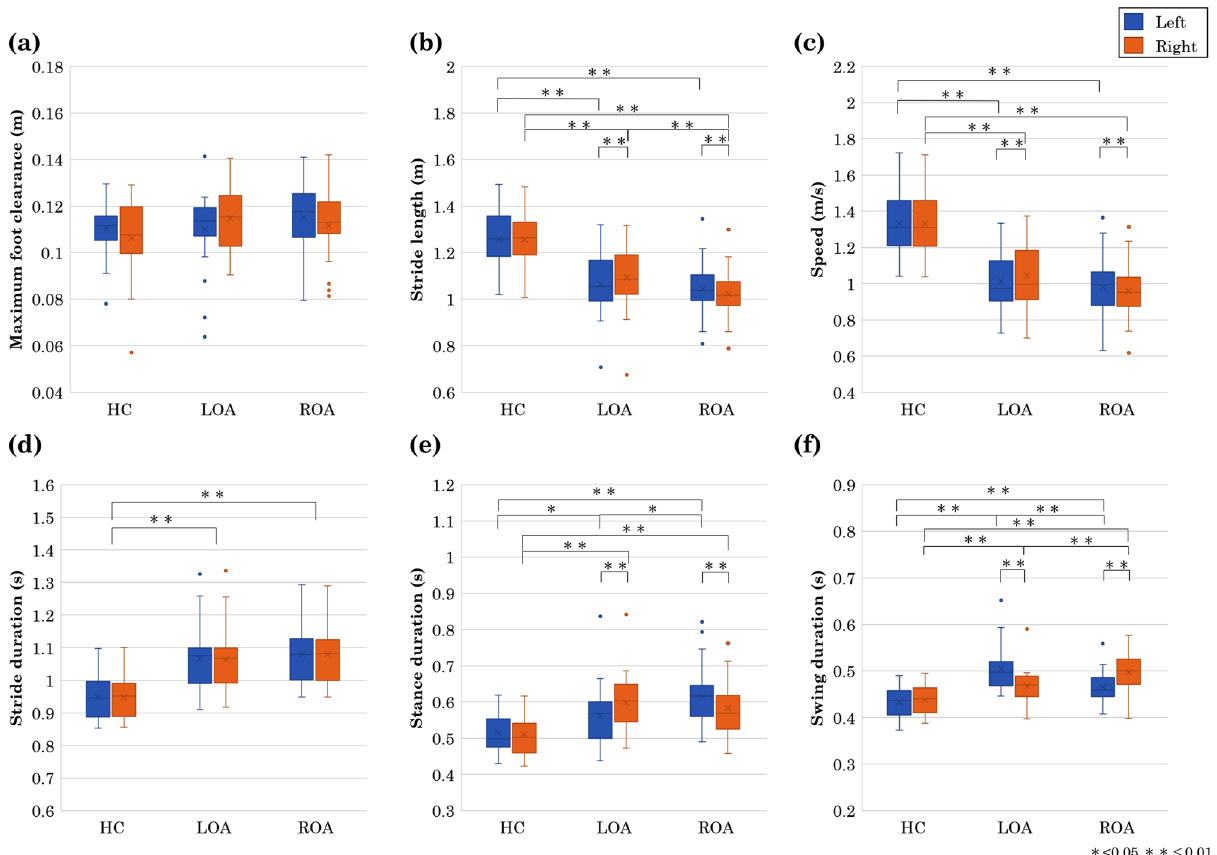
Figure 3. All gait parameters of ( a ) maximum foot clearance, ( b ) stride length, ( c ) speed, ( d ) stride duration, ( e ) stance duration, ( f ) swing duration. Blue is the left leg, orange is the right leg, and error bars indicate the SD. From left to right: healthy control (HC), left hip osteoarthritis (LOA), right hip osteoarthritis (ROA). * indicates significance at p < 0.05 and ** indicates significance at p < 0.01 from the midline was examined with the swing leg side as (+) and the stance leg side as (-) (Fig. 2h,i). The LD farthest from the midline to the swing legs side was defined as the maximum, and the LD closest to the stance legs side was defined as the minimum (Fig. 2h). In the sagittal plane, the stride length of the patient with hip OA is shorter than that of the HC, but the maximum foot clearance does not seem to be significantly different (Fig. 2d). Therefore, the foot trajectory of the patient with hip OA shrinks only in the direction of walking. The foot trajectory in the horizontal and frontal planes of the HC and the patient with hip OA appears to be very dif- ferent (Fig. 2e,f). The foot trajectory in the horizontal and frontal planes are in approximate symmetry in the HC, but in asymmetry and varied in the patient with hip OA, and the foot trajectory of the unaffected side is more medial than that of the affected side(Fig. 2e,f). In addition, the foot trajectory of the affected side of the patients of hip OA did not go medially, but spread laterally in some patients. However, the variation could be caused by individual differences(Fig. 2e,f). Therefore, the three-dimensional foot trajectory also appears to have a larger variation for the unaffected side limb of the ROA than the affected side limb of the LOA(Fig. 2b,c). Due to space limitation, we show only important statistical results. All results of the statistical test are shown in the supplementary information. Spatial gait parameters. The spatial gait parameters of the left and right lower limbs for HC, LOA, and ROA, i.e., maximum foot clearance and stride length are shown in Fig. 3a,b. Mixed ANOVA was performed for the mean of each gait parameter of HC, LOA, and ROA (Supplementary Table S1). Because significant interac- tions were found in the maximum foot clearance ( F ( 2, 72 ) = 3.94 , p = 0.024 , η 2 p = 0.099 )and stride length ( F ( 2, 72 ) = 11.82 , p < 0.001 , η 2 p = 0.247 ), we conducted the post hoc test for these gait parameters. When the simple effect of the group was found, we conducted a multiple comparison using Shaffer’s method. The results are shown in Table 2. For maximum foot clearance (Fig. 3a), there was no significant different between HC, LOA, and ROA. The stride lengths (Fig. 3b) in patients with LOA and ROA were significantly shorter in both the affected and unaffected sides than those in the HC. The stride length was significantly shorter in the affected side than in the unaffected side for both the patients with LOA and ROA. For the LD at swing phase of spatial gait parameters, the mean, maximum and minimum LDs of the left and right lower limbs of the HC, and the patients with LOA and ROA from the horizontal plane during toe off,